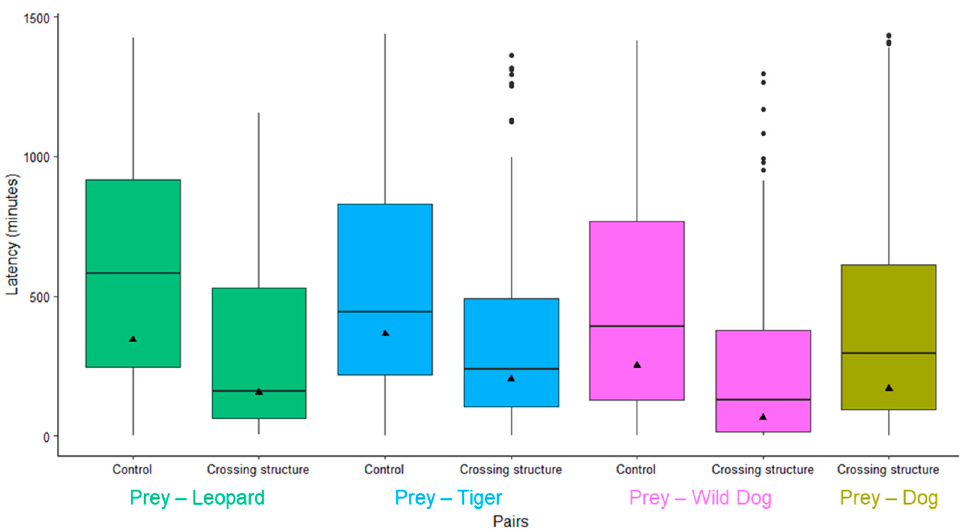
Figure 3. Comparison of geometric mean latencies (black triangle) and median latencies between prey–leopard, prey–tiger, prey–wild dog and prey–dog pairs at crossing structures and control site. Error bars indicate 95% confidence intervals. Black dots represent outliers. Table 2. Geometric mean latencies (minutes) between prey–predator sequences for different wild predator species and free-ranging dogs at crossing structures on NH 44, Pench Tiger Reserve, Maharashtra, India.